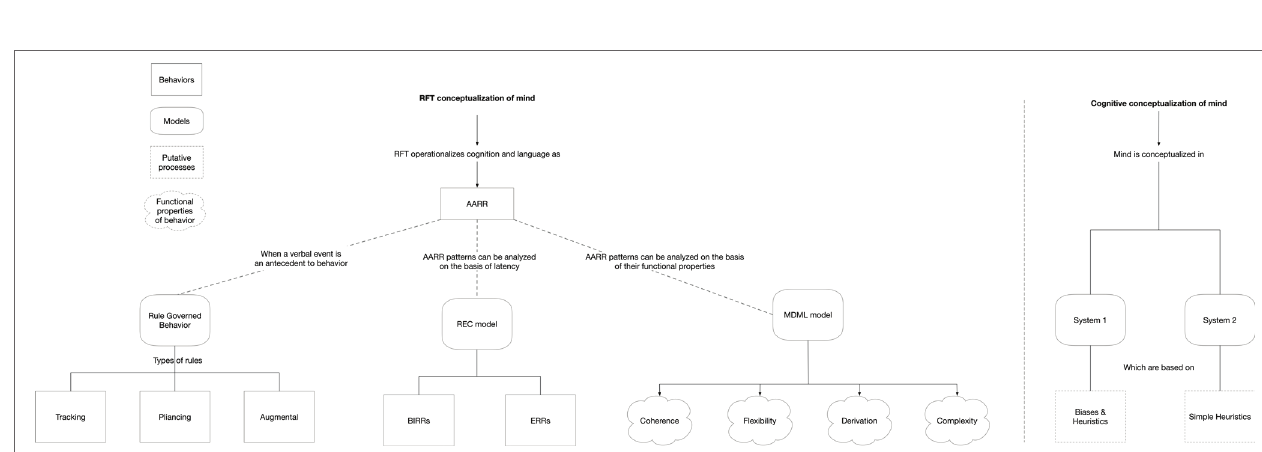
FIGURE 2 | Contingency-shaped behavior and rule-governed behavior, in relation to tracking and pliancing.